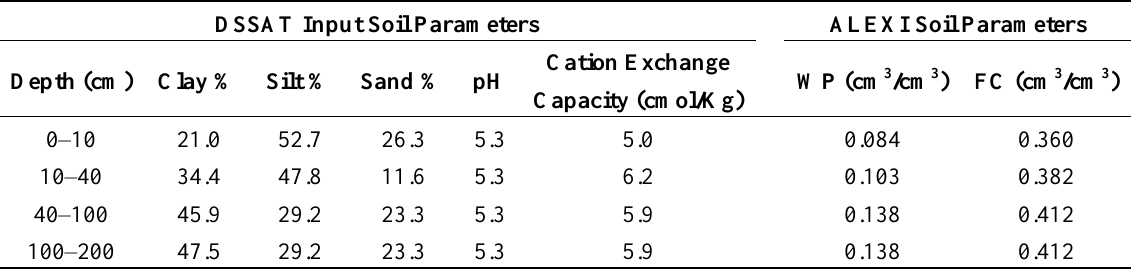
Table 1. Soil characteristics at Belle Mina, Alabama USA study